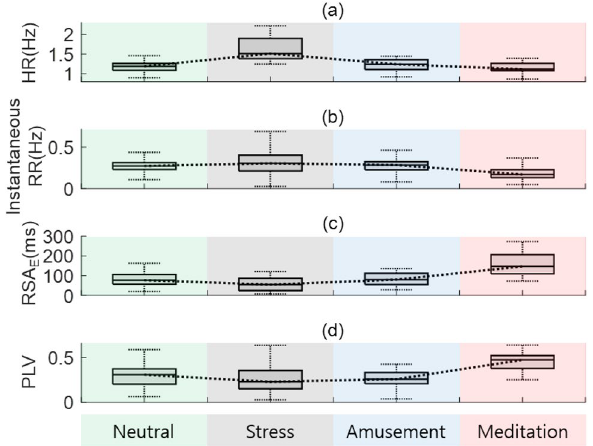
Figure 8. Vital signs (HR and RR) and RSA indices (RSA E and PLV) for 4 affective states. Box plots of ( a ) HR, ( b ) instantaneous RR, ( c ) RSA E , and ( d ) PLV.